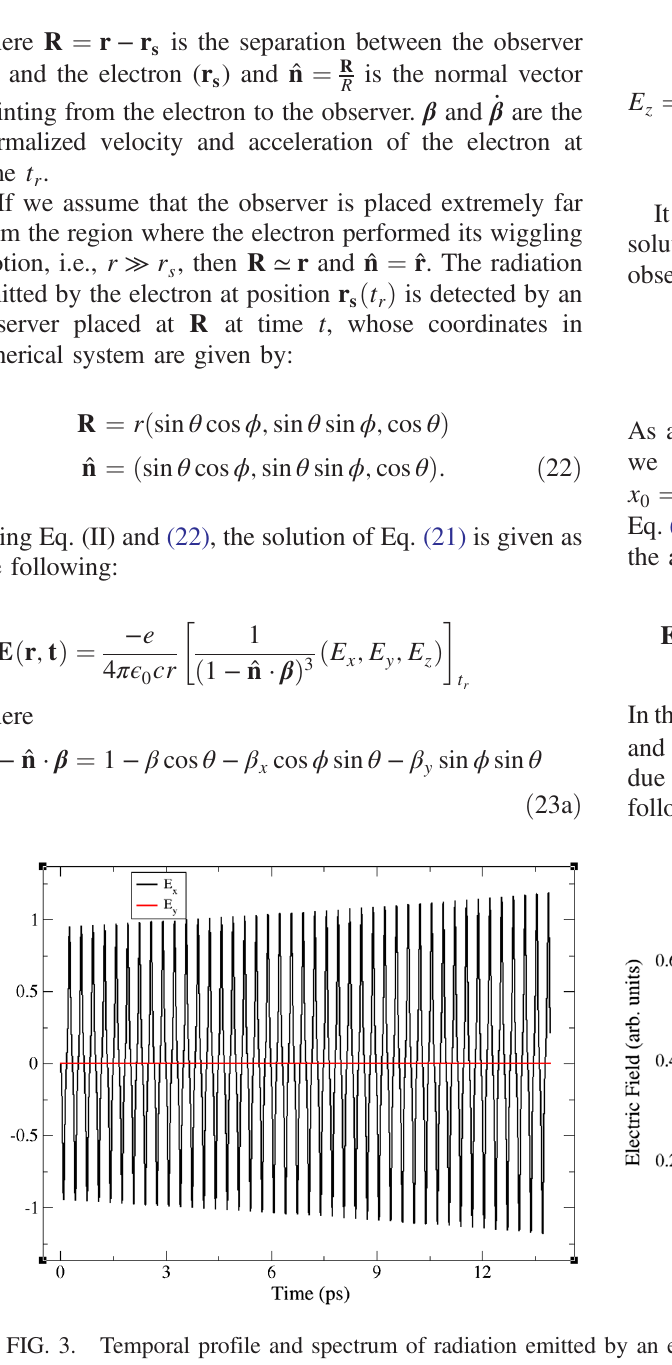
FIG. 3. Temporal profile and spectrum of radiation emitted by an electron injected on-axis of an undulator with K ¼ 0 . 5